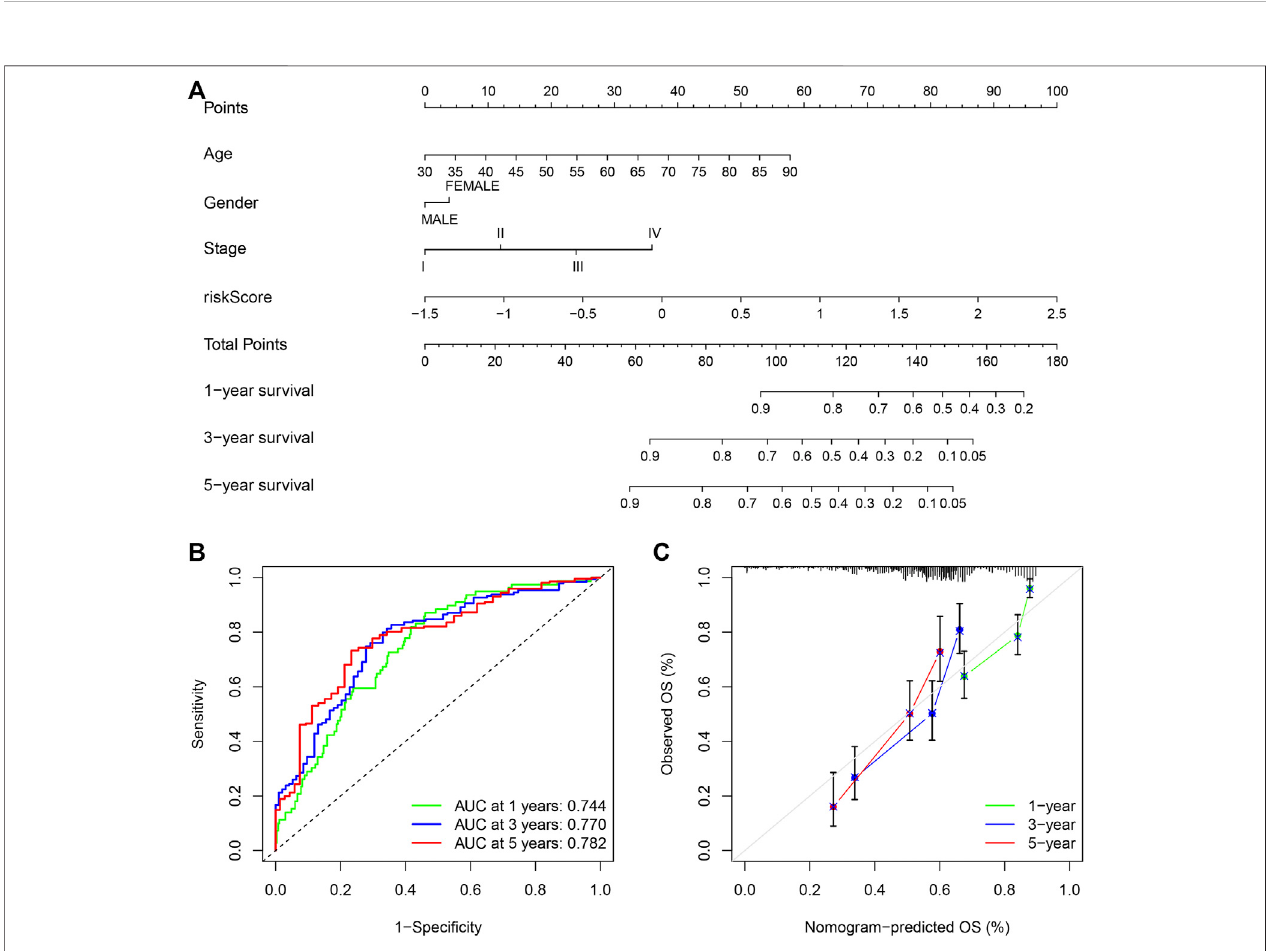
FIGURE 5 | (A) Nomogram of age, gender, stage and risk score as independent prognostic factors for predicting overall survival. (B) The receiver operator characteristic (ROC) curves and the area under the curve (AUC) of the predictions for 1-, 3-, and 5-years of the nomogram for TCGA-BLCA cohort. (C) The calibration chart of the nomogram for TCGA-BLCA